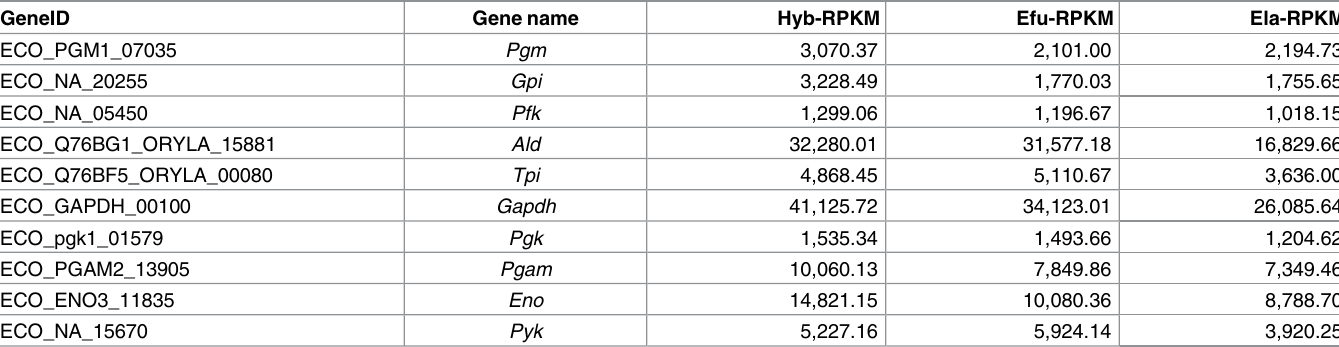
Table 2. RPKMs of glycolytic genes in the three groupers.